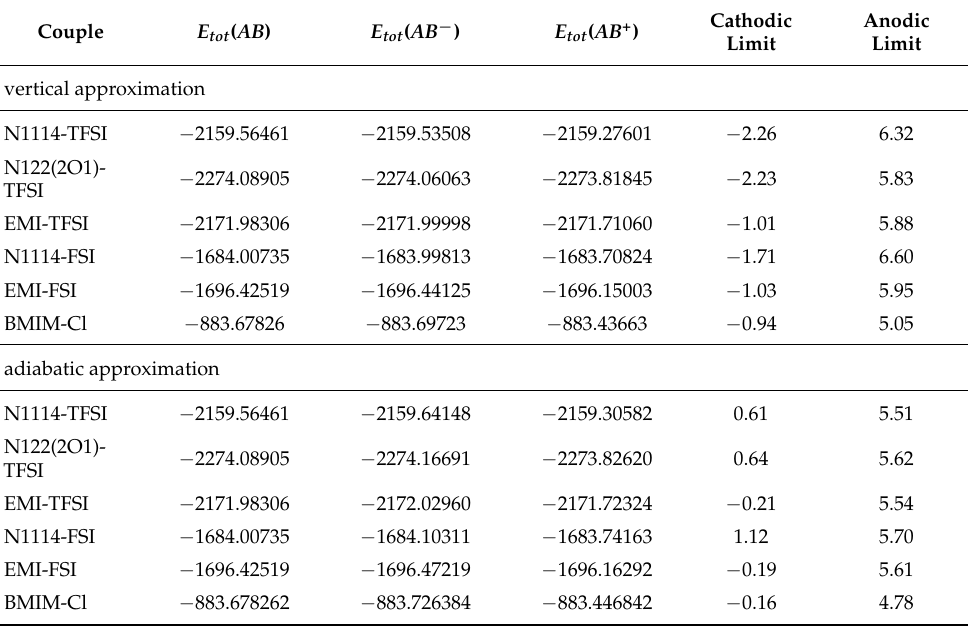
Table 9. Electronic energy (in atomic units) of the neutral ionic couples and of the ionic couple with the addition or removal of an electron, without or with the possible relaxation of the geometry and derived cathodic and anodic limits (in V). All calculations were performed at the B3LYP/6-31G** level of theory in a polar